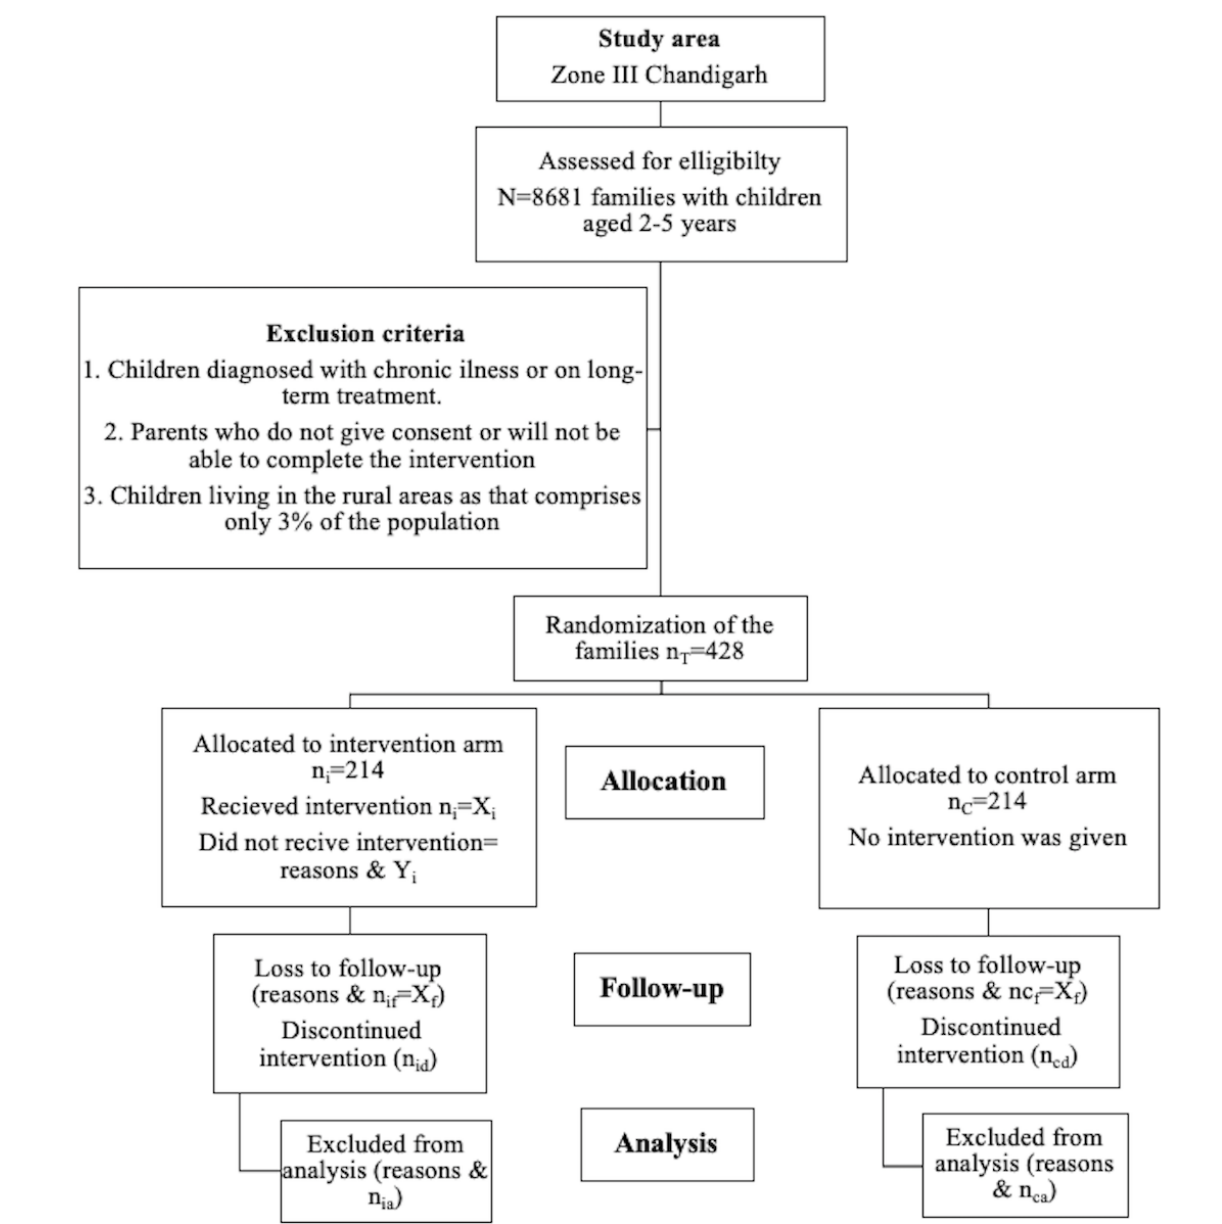
Figure 1. CONSORT statement flow diagram for the intervention